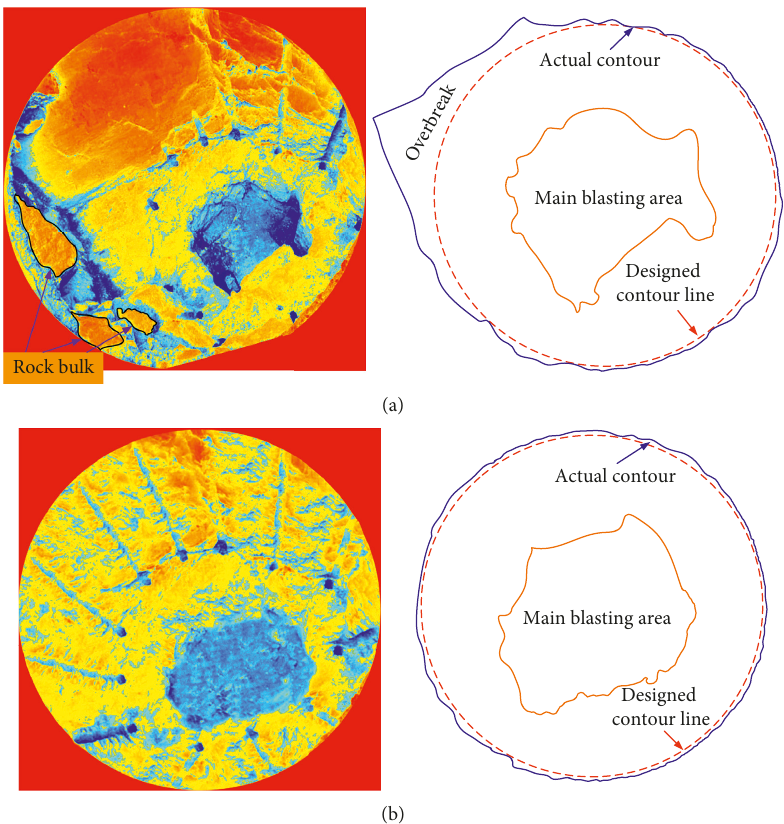
Figure 12: Excavation results of rock wells based on (a) presplit blasting and (b) smooth blasting.